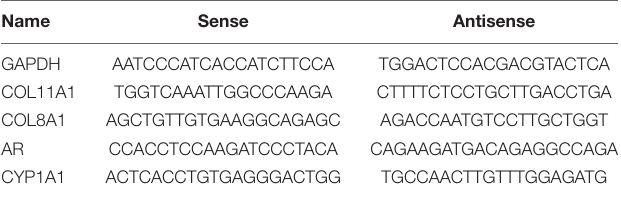
TABLE 2 | Sequences of primers used for qRT-PCR analysis of mRNA